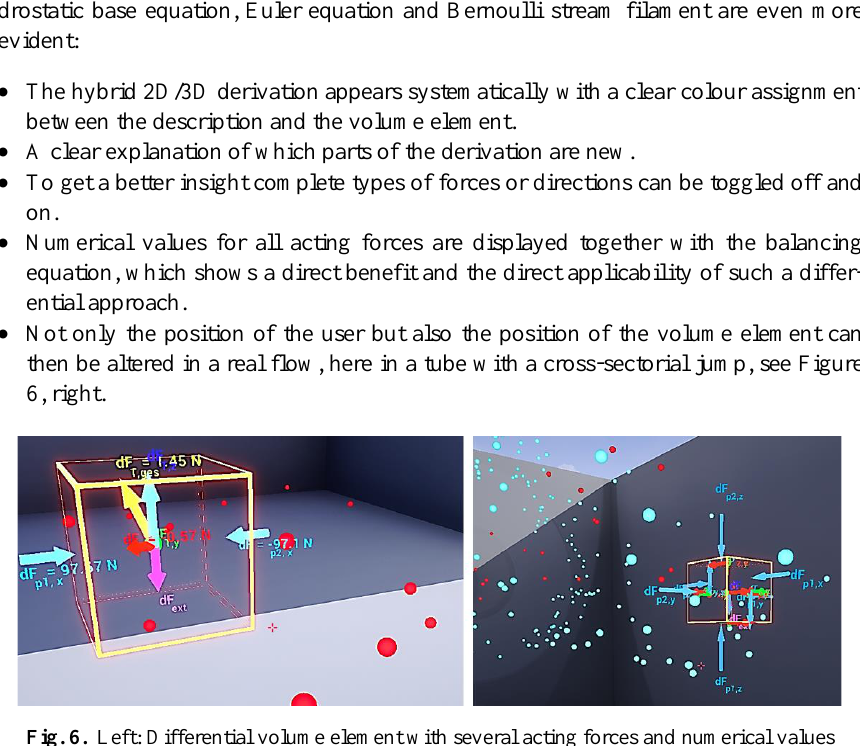
Fig. 6. Left: Differential volume element with several acting forces and numerical values in the derivation of the Euler equation, forces only plotted in two spatial directions. Right: Cubic differential volume element with several acting forces in the derivation of the Navier-Stokes